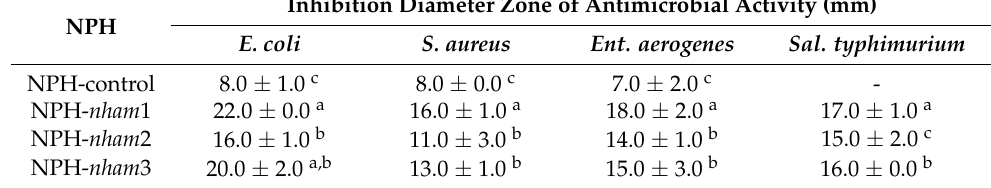
Table 4. Antimicrobial activity of Nham protein hydrolysates from different fractions at the highest antioxidant